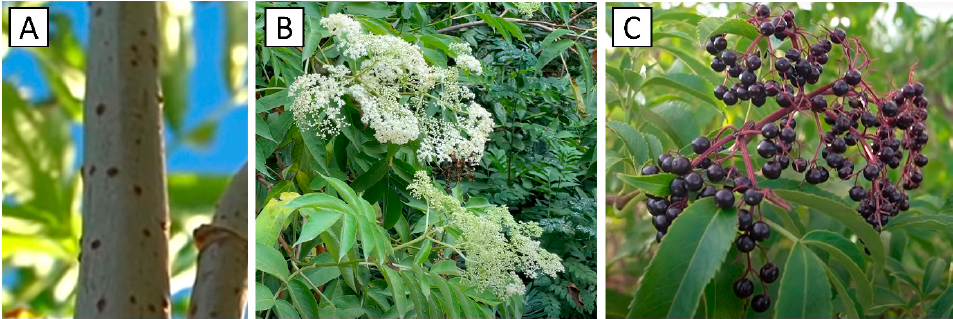
Figure 1. Some distinctive morphological features of Sambucus nigra . ( A ) Young trunk with lenticels; ( B ) umbels with white flowers; ( C ) dark-colored fully ripe fruits. Fruits are commercially considered berries.